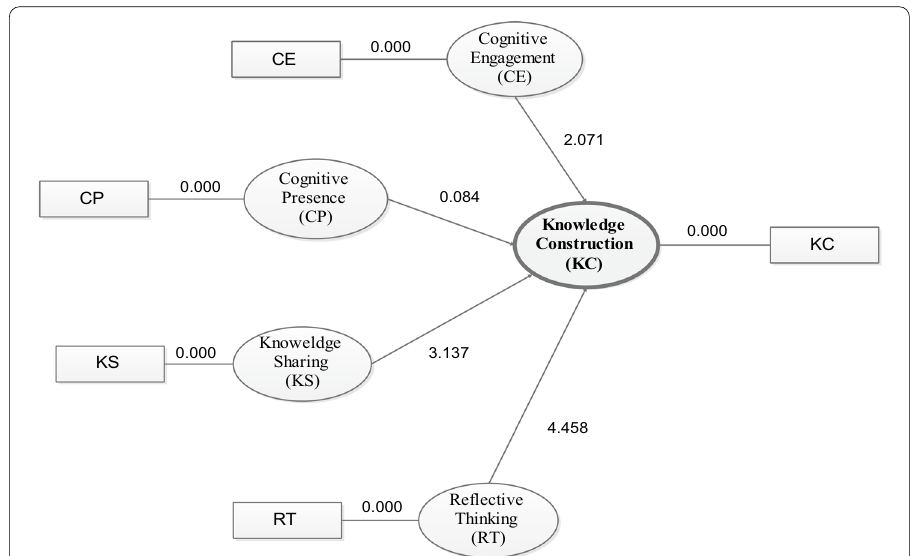
Fig. 5 Two‑stage approach